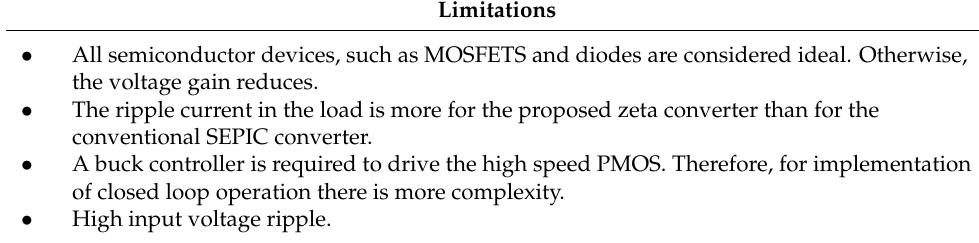
Table 4. Limitations of the proposed